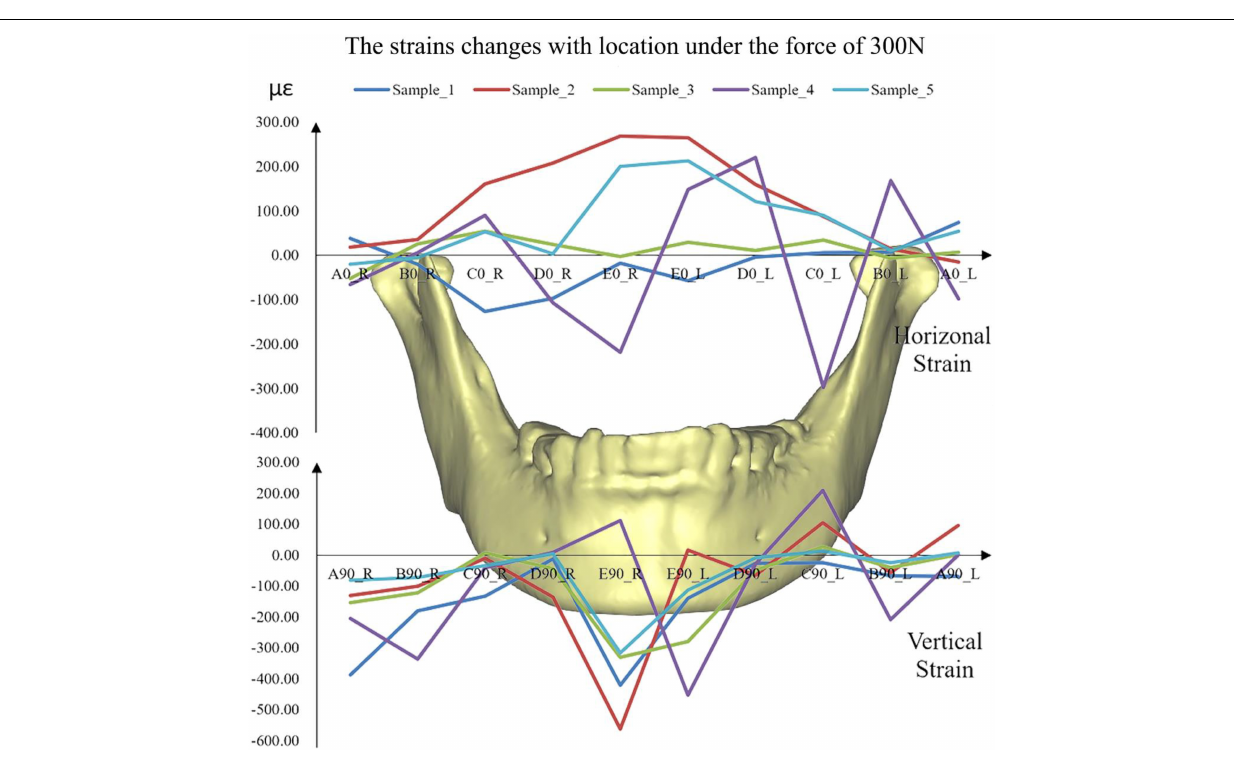
FIGURE 6 | The simulated strains from FE models of all the five samples under the force of 300 N. A located at the bilateral mandibular condyle necks, B located at the bilateral mandibular angles, and C, D, and E located at the bilateral mandibular bodies. 0 and 90 represented the horizontal and vertical directions, respectively. R and L represented the right and left sides,